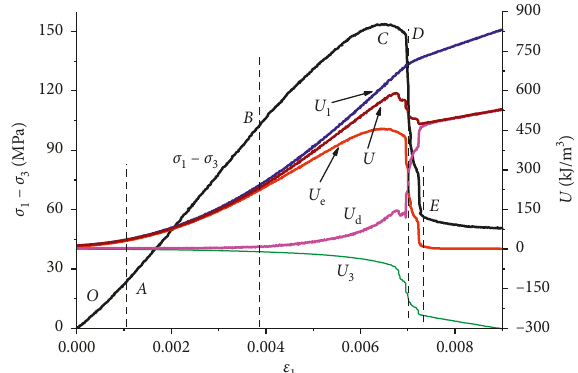
Figure 4: Energy curves of the rock sample under a confining pressure of 10